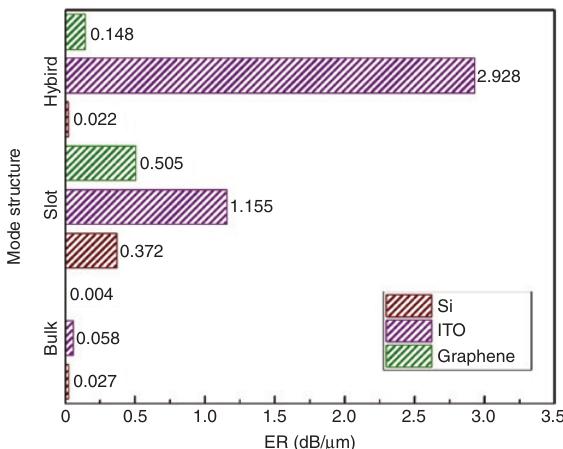
Figure 7: Electro-absorptive modulation (EAM) linear device perfor- mances characterized by extinction ratio (ER) for all the